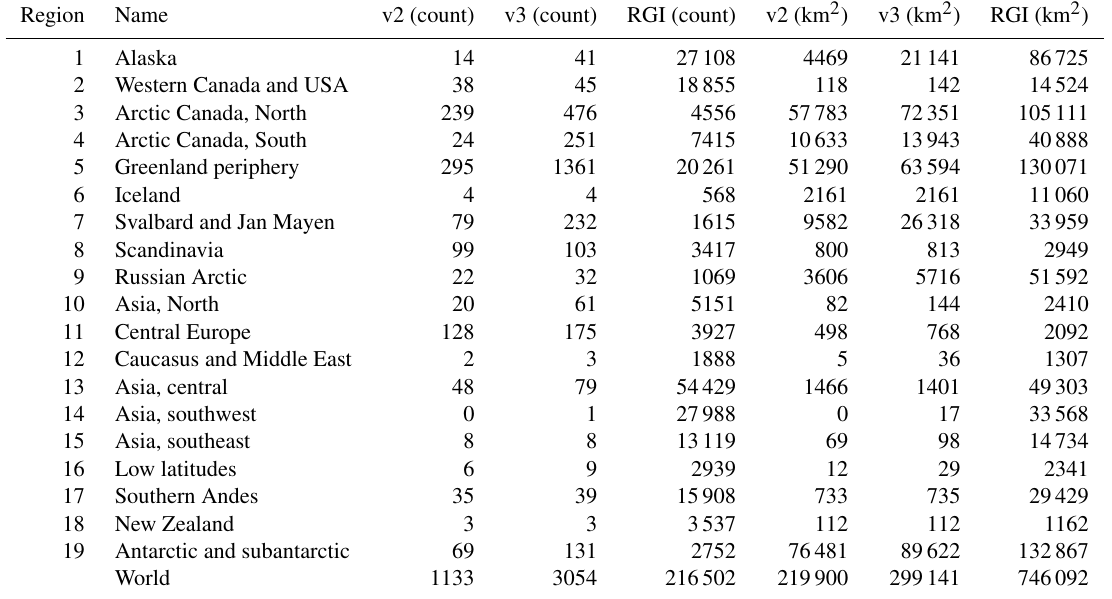
Table 3. GlaThiDa coverage for each glacier region mapped in Fig. 7. The count and total area (km 2 ) of RGI glacier outlines with at least one (point, elevation band, or glacier-wide) thickness are listed for GlaThiDa v2 (2016) and v3 (2019) alongside the total for all RGI glaciers.